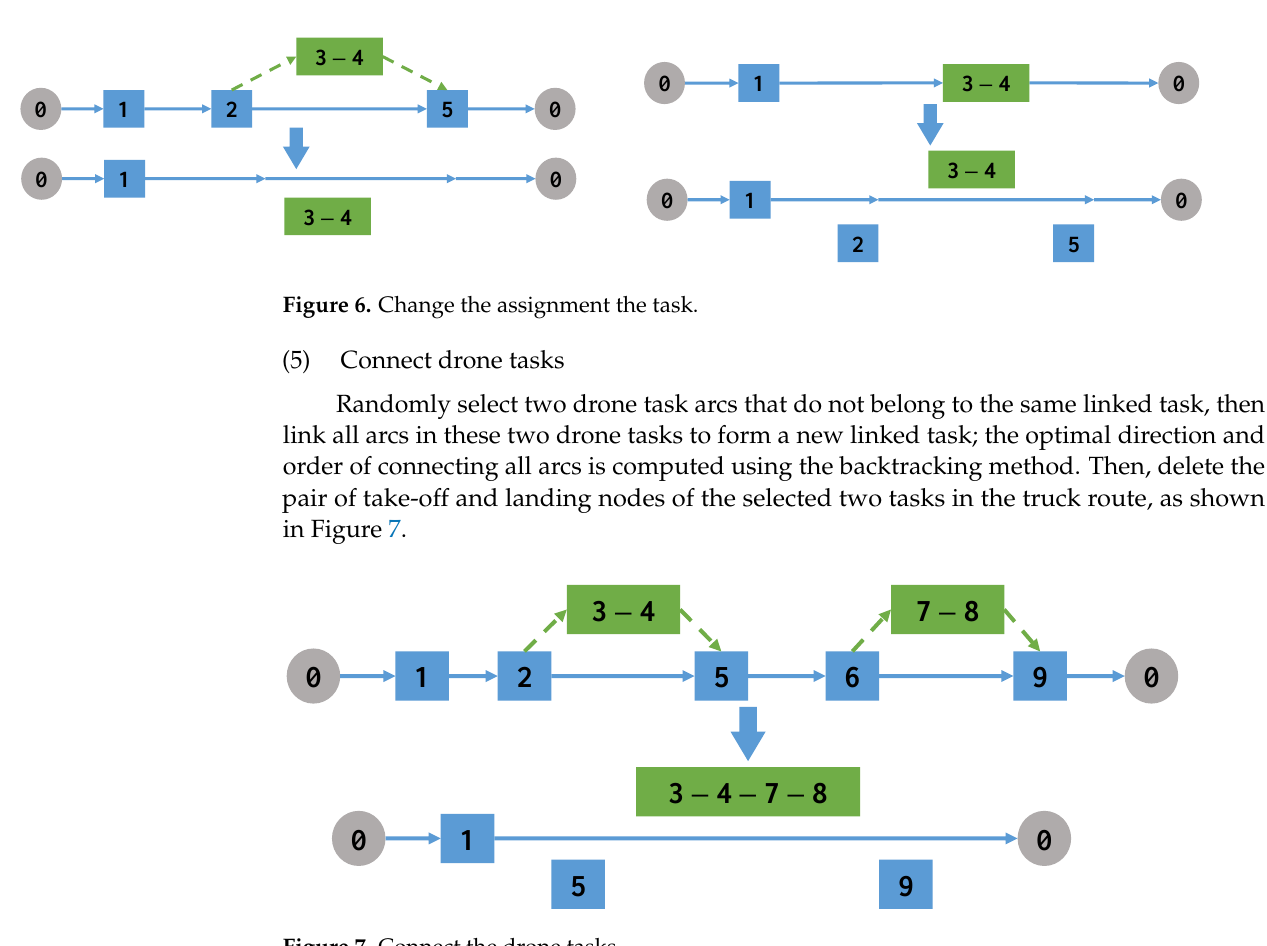
Figure 7. Connect the drone tasks.